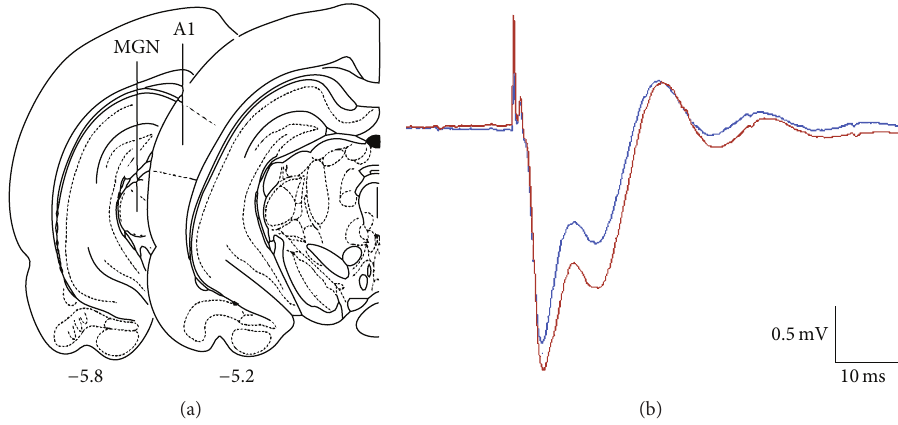
Figure 1: (a) Typical placements of the stimulating and recording electrodes in the MGN and A1, respectively. Atlas images adapted from Paxinos and Watson [18]. (b) Typical fPSPs recorded in A1 following single-pulse MGN stimulation consisted of two distinct negative peaks occurring at approximately 7 and 15 ms after the stimulation artifact (initial sharp, positive spike). Blue (smaller amplitude) and red (larger amplitude) traces represent fPSPs recorded before and after LTP induction, respectively.